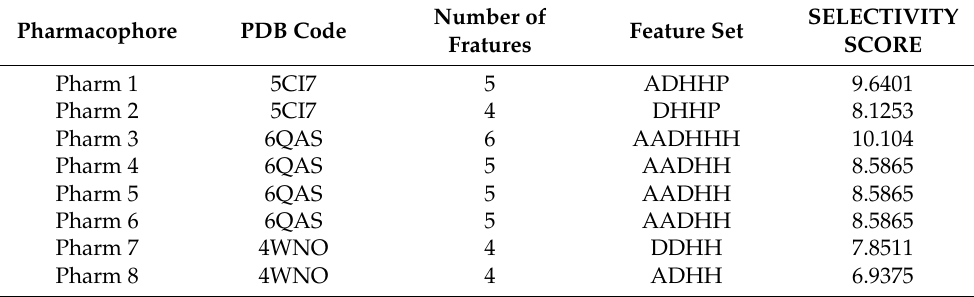
Table 1. Scoring of selected